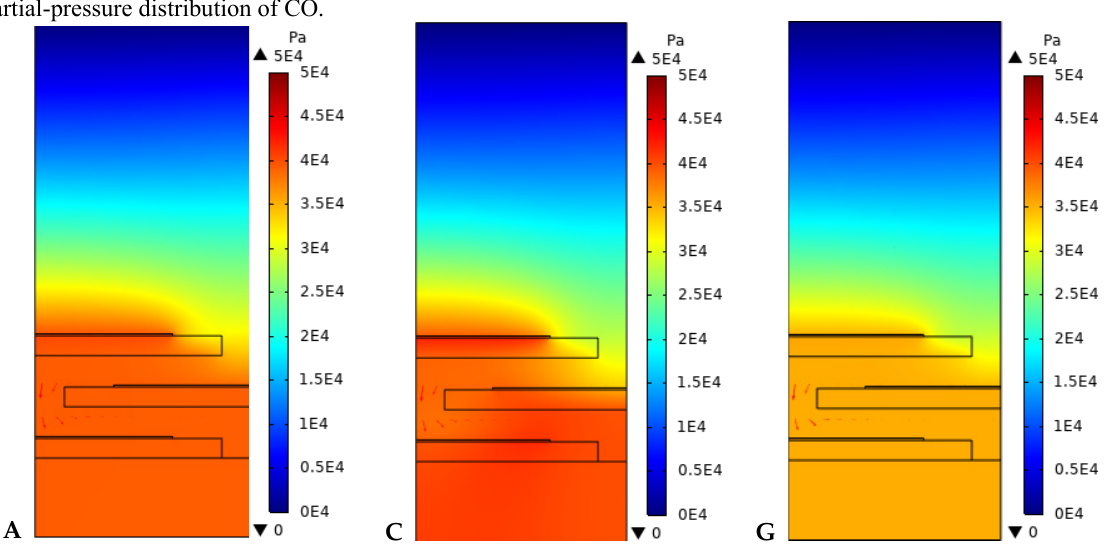
Figure 3. Partial-pressure distributions of CH 4 , CO 2 , H 2 and CO in cases A, C and G.